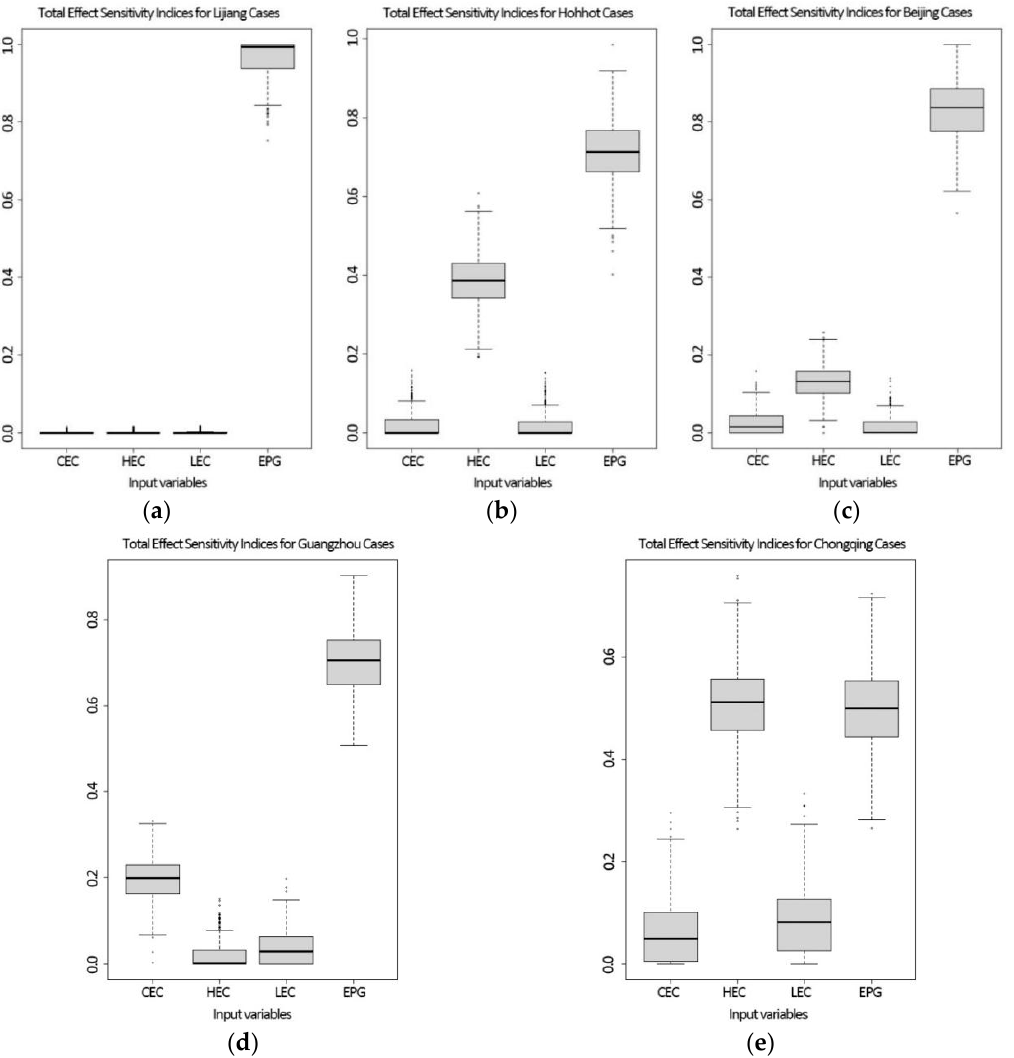
Figure 10. Sensitivity analysis of each component of the STVP energy performance on sloped roofs to the ESR. ( a ) Case 1: Lijiang; ( b ) Case 2: Hohhot; ( c ) Case 3: Beijing; ( d ) Case 4: Guangzhou; ( e ) Case 5: Chongqing.